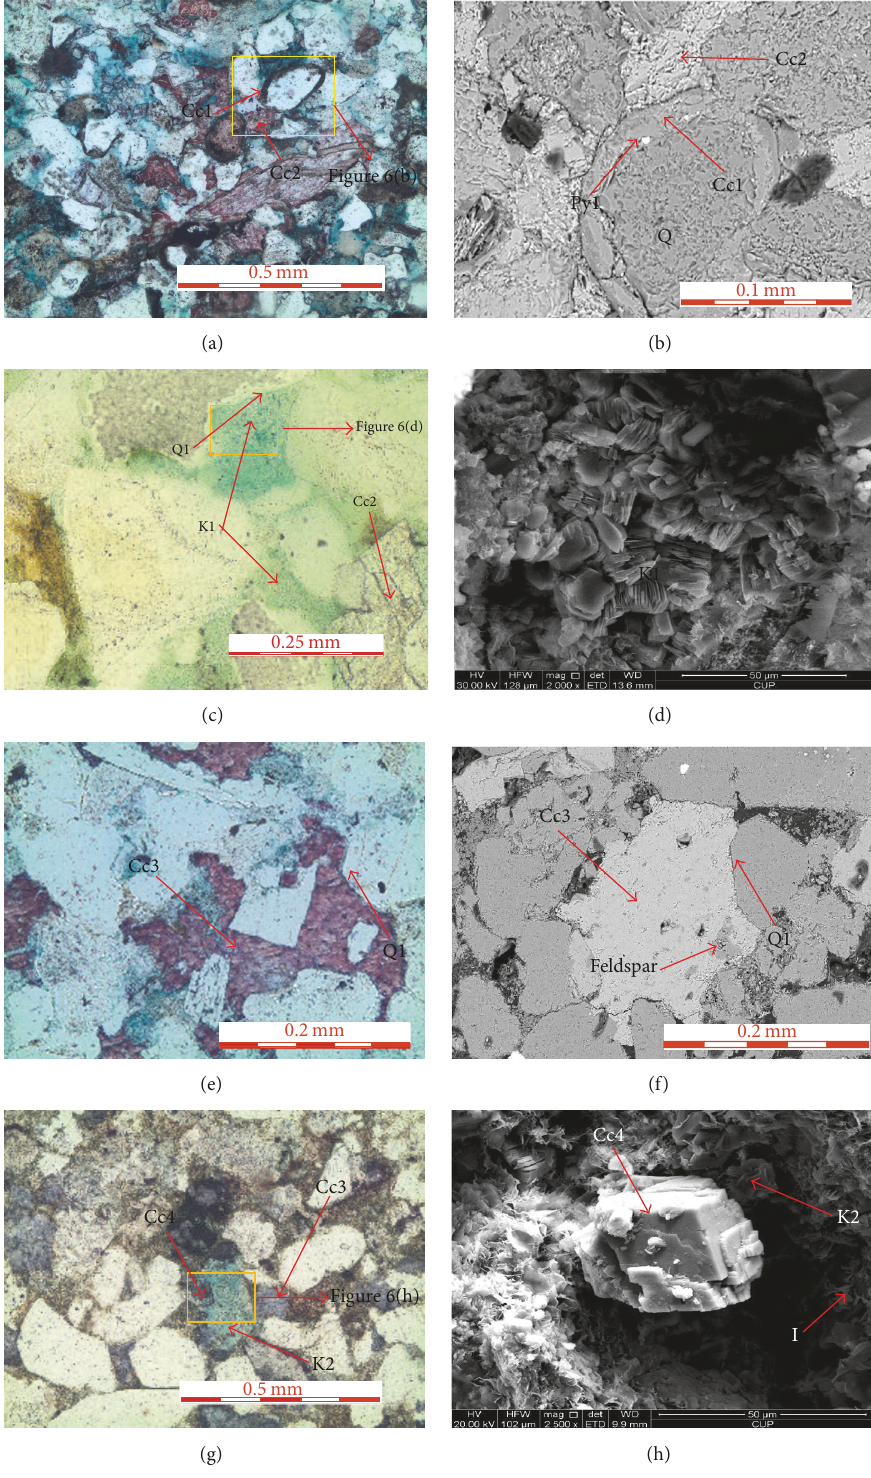
Figure 6: Morphological features of diagenetic products in Es of Dongying Sag . ((a) Well Shi127 2180.8 m, micritic high-Mg calcite (Cc1) and medium-coarse calcites (Cc2); (b) Well Shi127 2180.8 m, local amplification of (a), Cc1, Cc2, and Py1; (c) Well Xin 154 2960.50 m, Cc2 partly filled in primary pores and the outer part was filled by K1; (d) Well Xin 154, 2960.50 m, local amplification of (c); (e) Well Niu110, 3004.80, dissolution of Cc3 and fillings in the outer of Q1; (g) Well FS1, 4322.40 m, Cc4 occurred in the outer of kaolinization feldspar (K2); (h) Well FS1, 4322.40 m, local amplification of